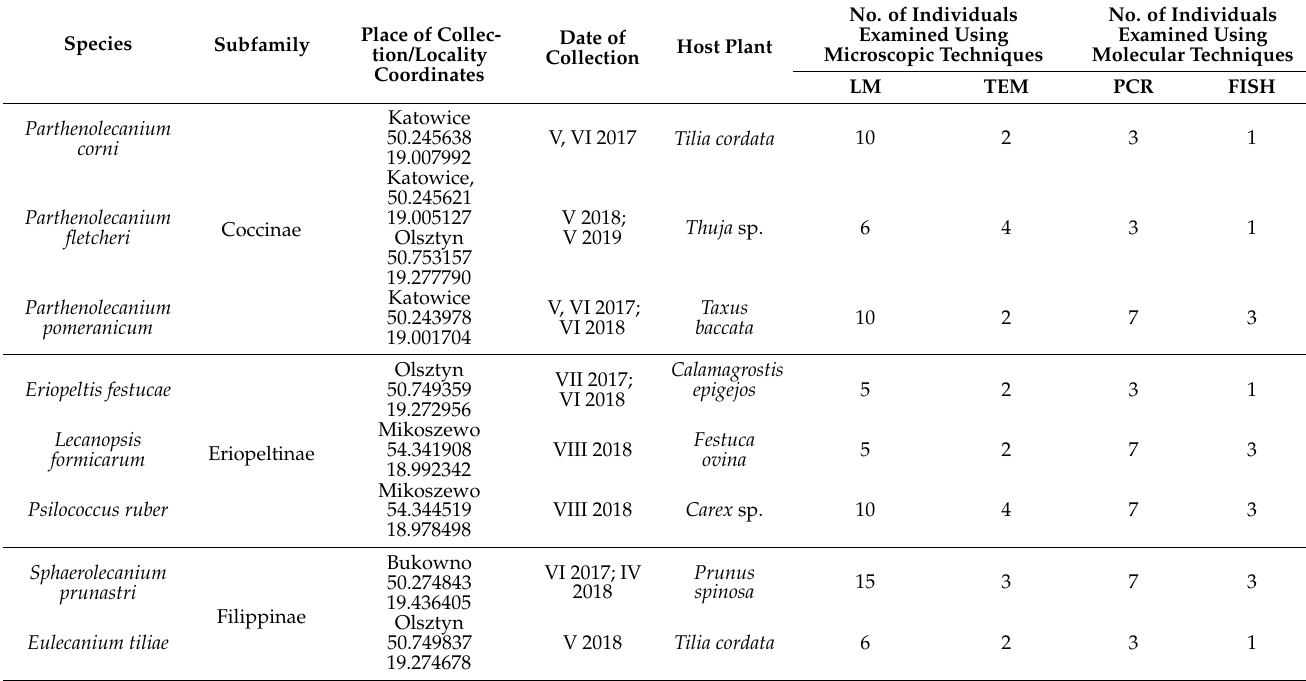
Table 1. List of investigated species with collection details and number of individuals used in each method applied. Species Subfamily Place of Collec-